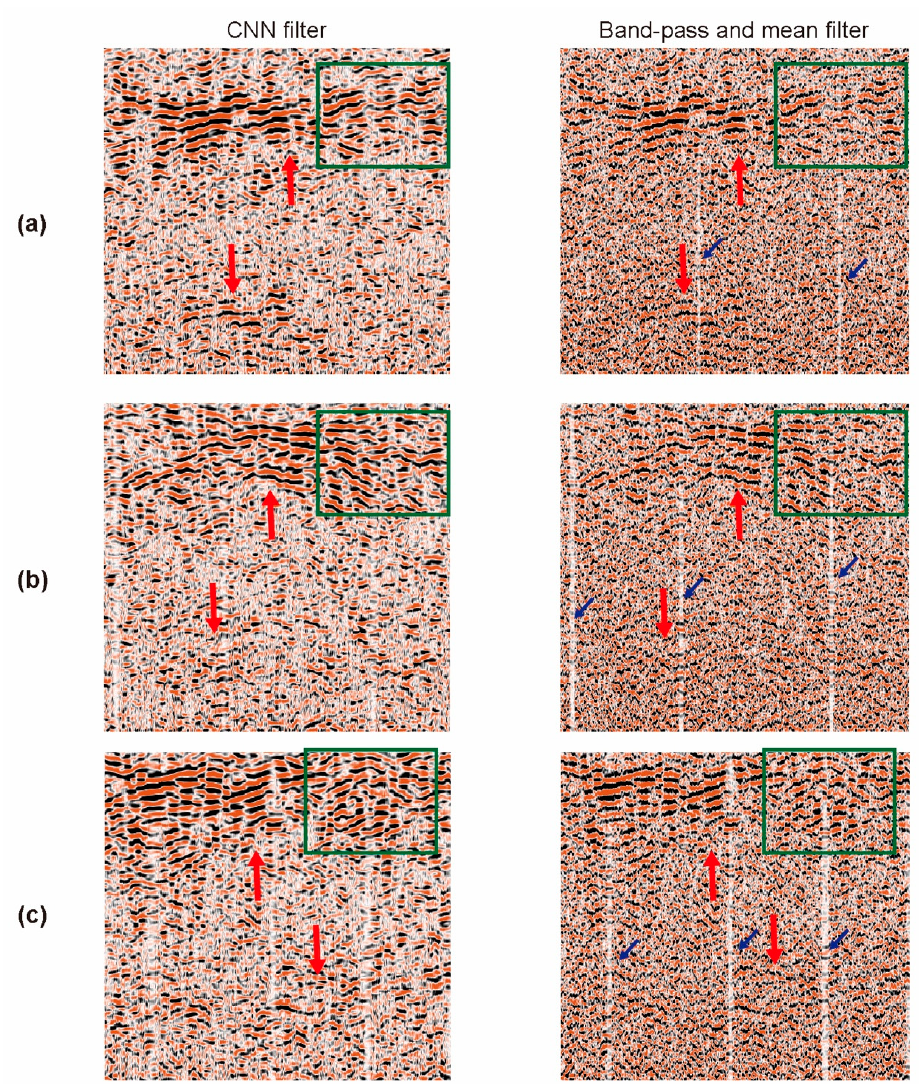
Figure 15. Detailed comparisons of the magnified images in the three rectangular regions of Figure 14d,e. ( a ) Region 1. ( b ) Region 2. ( c ) Region 3. The red up-toward and down-toward arrows indicate the signals at 500 and 600 ns, respectively. The blue arrows point out the strips of interference.